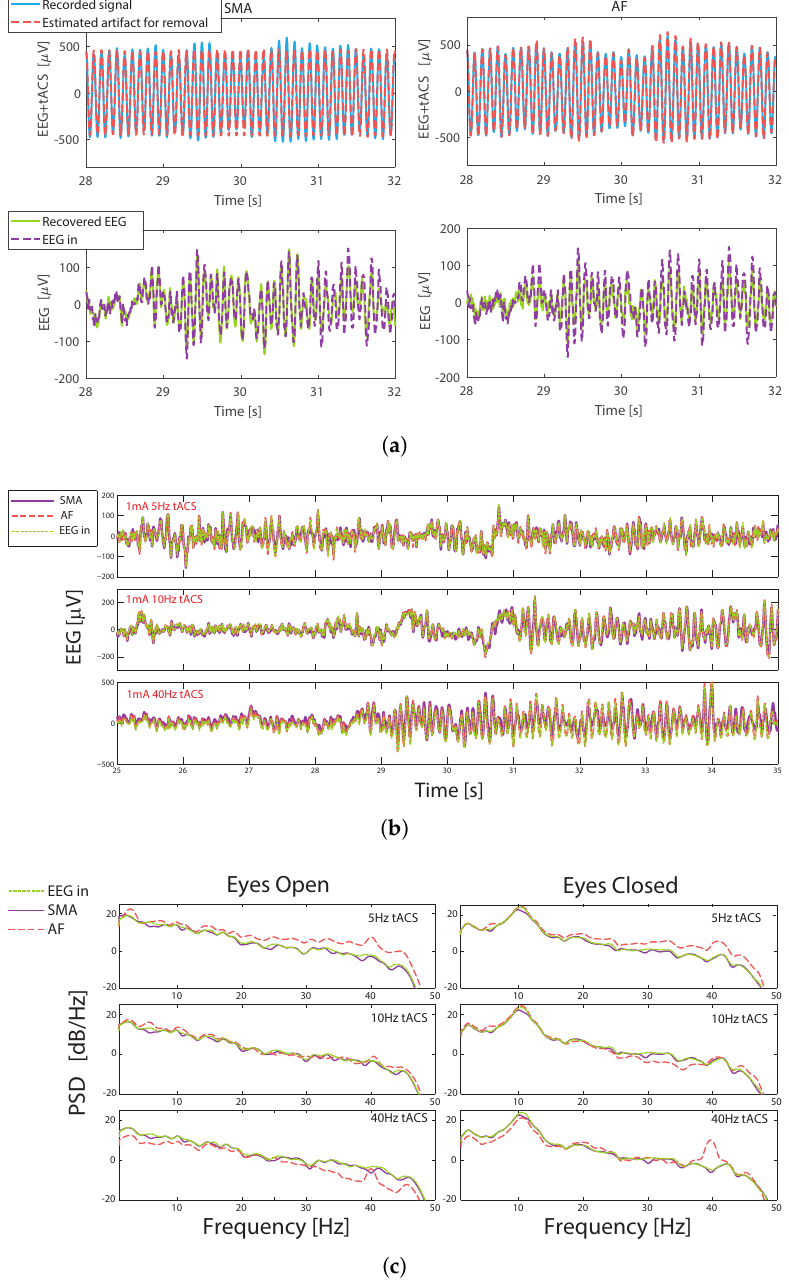
Figure 6. Illustrations of artifact removal from the phantom head. ( a ) The raw recorded signals and the artifacts which are estimated from these by the two algorithms. The recovered EEG signal compared to the one inputted to the phantom head is also shown. Traces are for a 10 Hz, 0.25 mA stimulation. ( b ) Example reconstructions for different tACS frequencies. All stimulation amplitudes are 1 mA. For both the SMA and AF approaches the recovered EEG signal visually closely matches that which is inputted into the head model. ( c ) Frequency domain representation. PSD at 0.25 mA stimulation, with the inputted EEG data split into eyes open and eyes closed